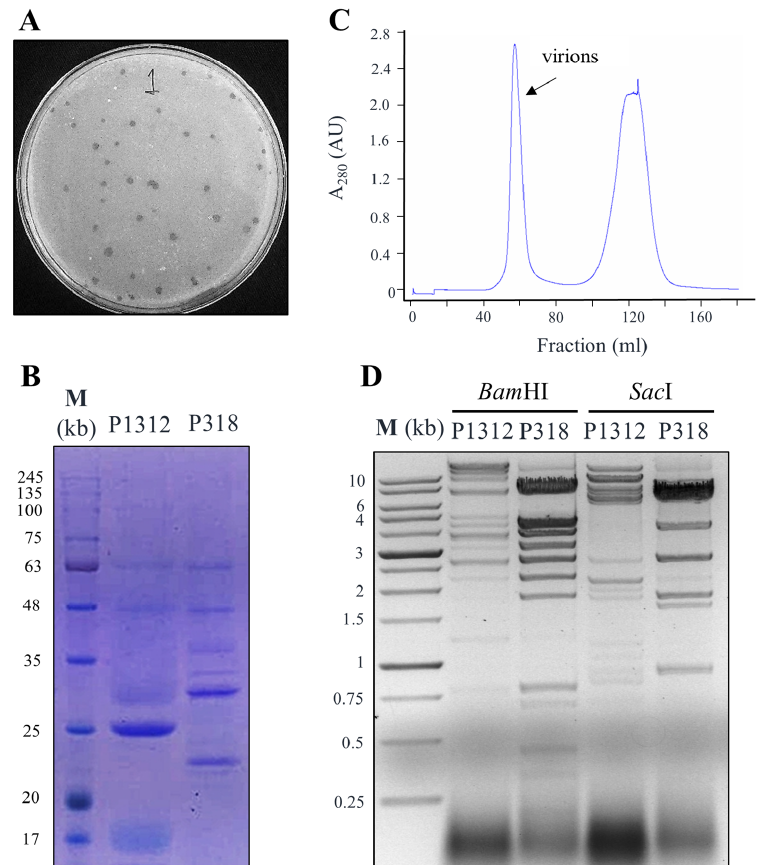
Figure 1. Isolation and purification of T. fusca bacteriophage P318. ( A ) Plaques formed in the lawn of T. fusca 10-1 strain in a CYC double-layer agar plate. ( B ) Protein compositions of P318 and P1312 virions analyzed by 12% polyacrylamide SDS-PAGE. ( C ) P318 virions were purified by the gel filtration chromatography using a Sephacyl S-500 column. ( D ) The di ff erential restriction patterns between P318 and P1312 after digestion with Bam HI or Sac I restriction